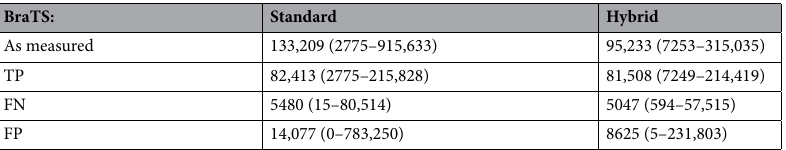
Table 3. Standard and Hybrid pipeline accuracy in brain tumour segmentation. Units displayed are volume 3 (mm ), given as median (range).